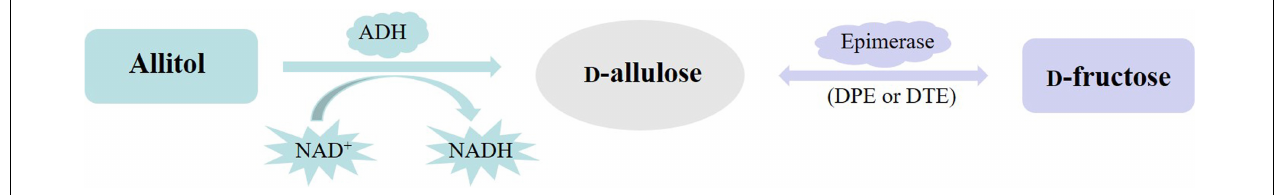
FIGURE 1 | D -Allulose biotransformation from allitol or D -fructose (ADH, NAD(P)-dependent alcohol dehydrogenase; DPE, D -psicose 3-epimerase; DTE, D -tagatose